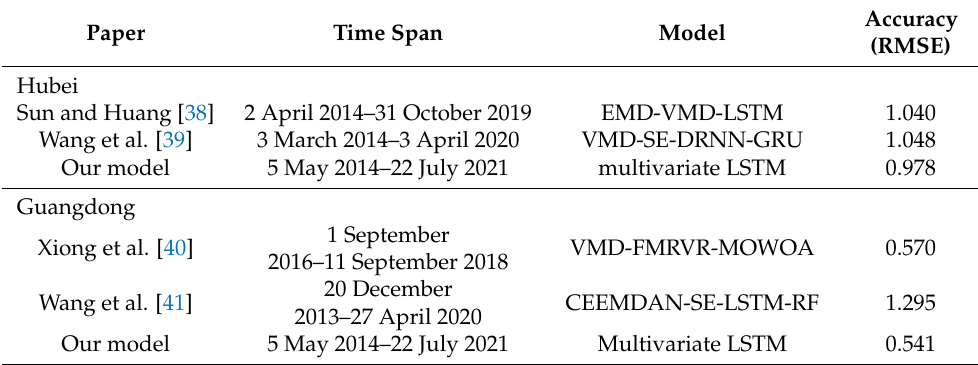
Table 6. Comparison of carbon price forecasting methods. Paper Time Span